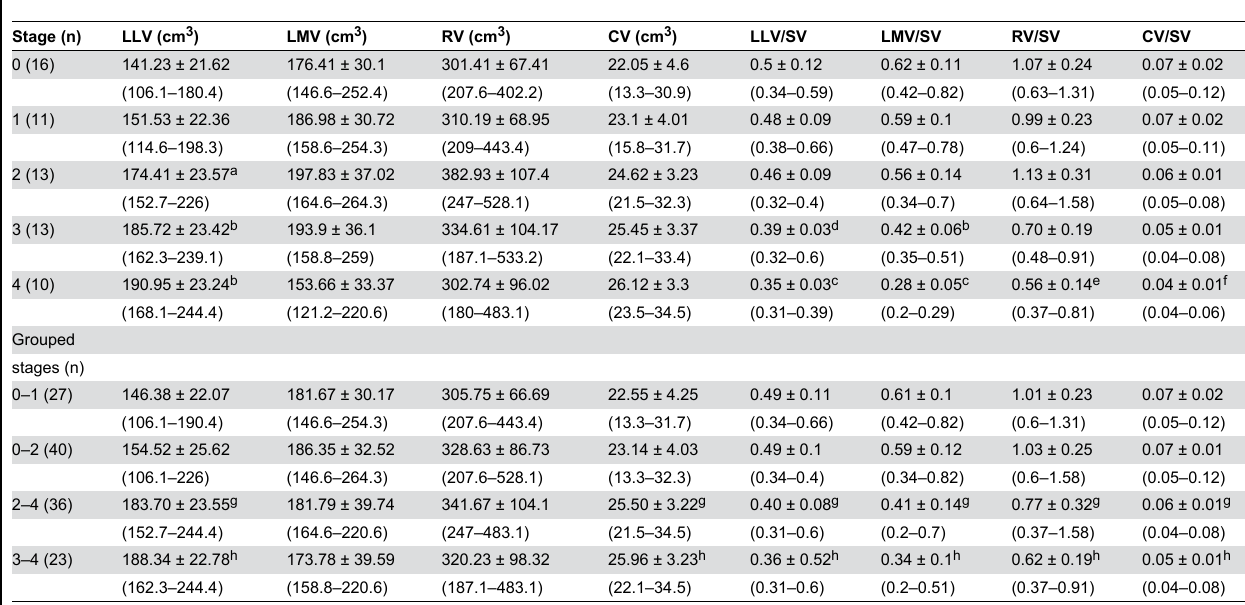
Table 3. Liver lobe volume parameters corresponding to stages of liver